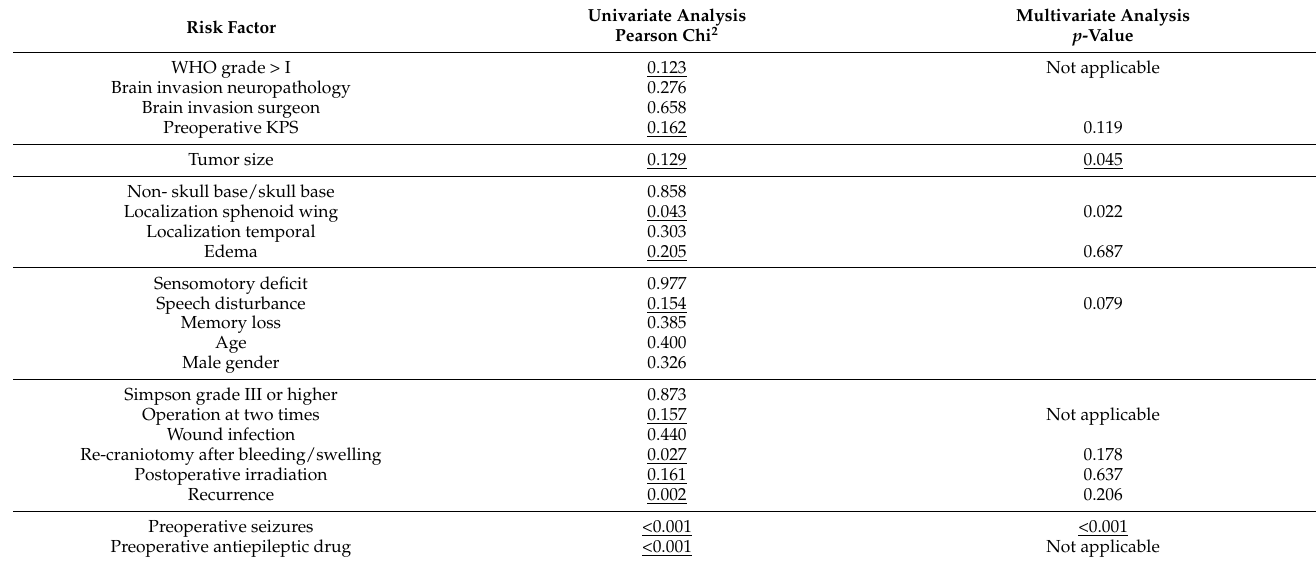
Table 5. Risk factors for postoperative status epilepticus.